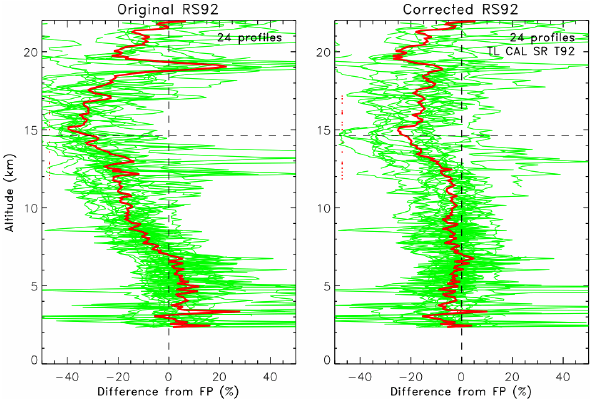
Fig. A3. Altitude profiles of the relative percentage difference be- Fig. 8. Altitude profiles of the relative percentage difference between RS92 and frostpoint hygrometer (green) tween RS92 and frost point hygrometer (green) and the mean of andthemeanofallprofiles(red)forthenighttimeMOHAVE2009dualsoundings,shownfortheoriginalRS92 all profiles (red) for the nighttime MOHAVE 2009 dual soundings, measurements (left) and after applying the calibration and time-lag corrections (right). Dashed line is the mean shown for the original RS92 measurements (left panel) and after ap- tropopause height, and tiny red dots are the individual tropopause estimates. plying the calibration and time-lag corrections (right panel). Dashed line is the mean tropopause height, and tiny red dots are the individ- ual tropopause